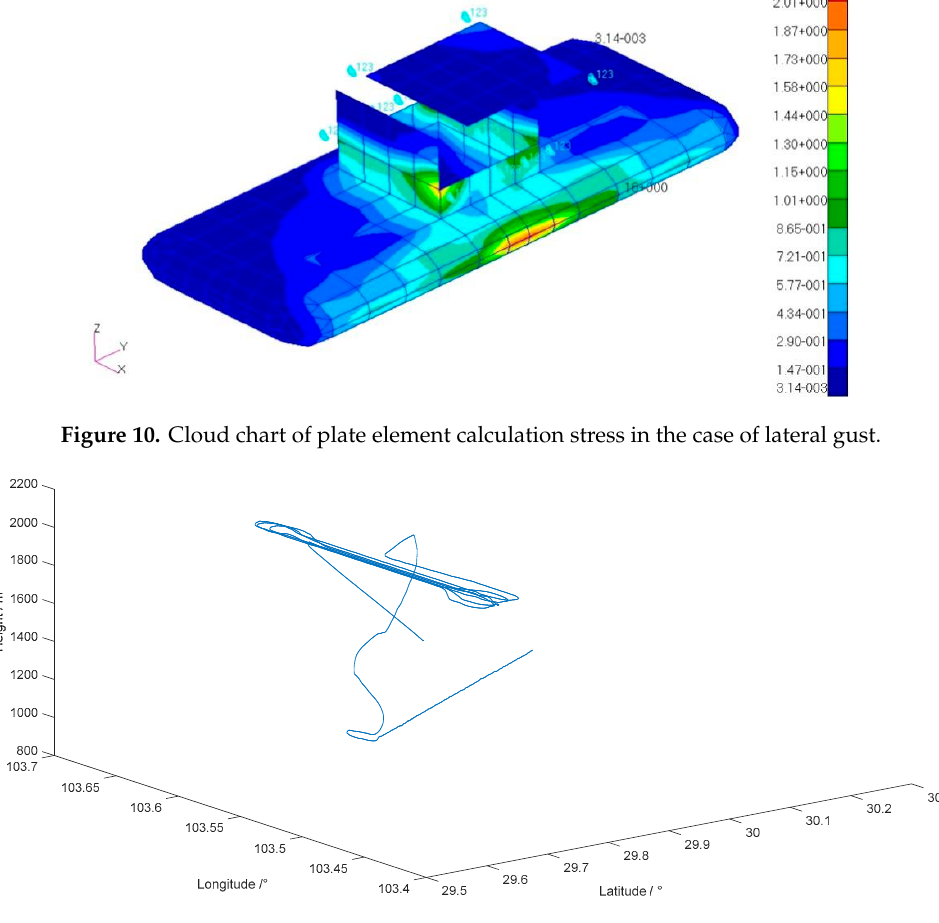
Figure 11. Flight Figure 11. Flight path.